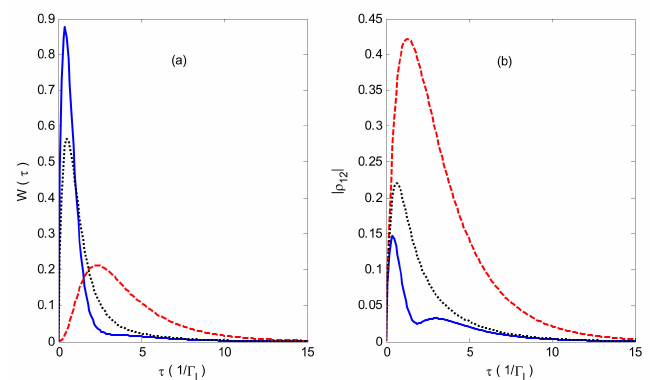
(cid:12) (cid:12) (cid:12) (cid:12) (cid:12) ρ 12 (cid:12) as a function of time τ .